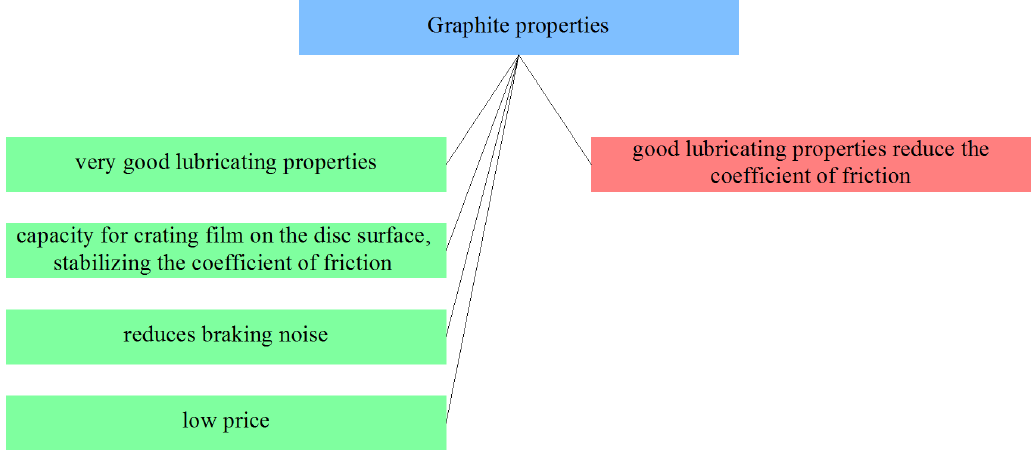
Figure 23: Selected graphite composites properties from the point of view of applicability in friction